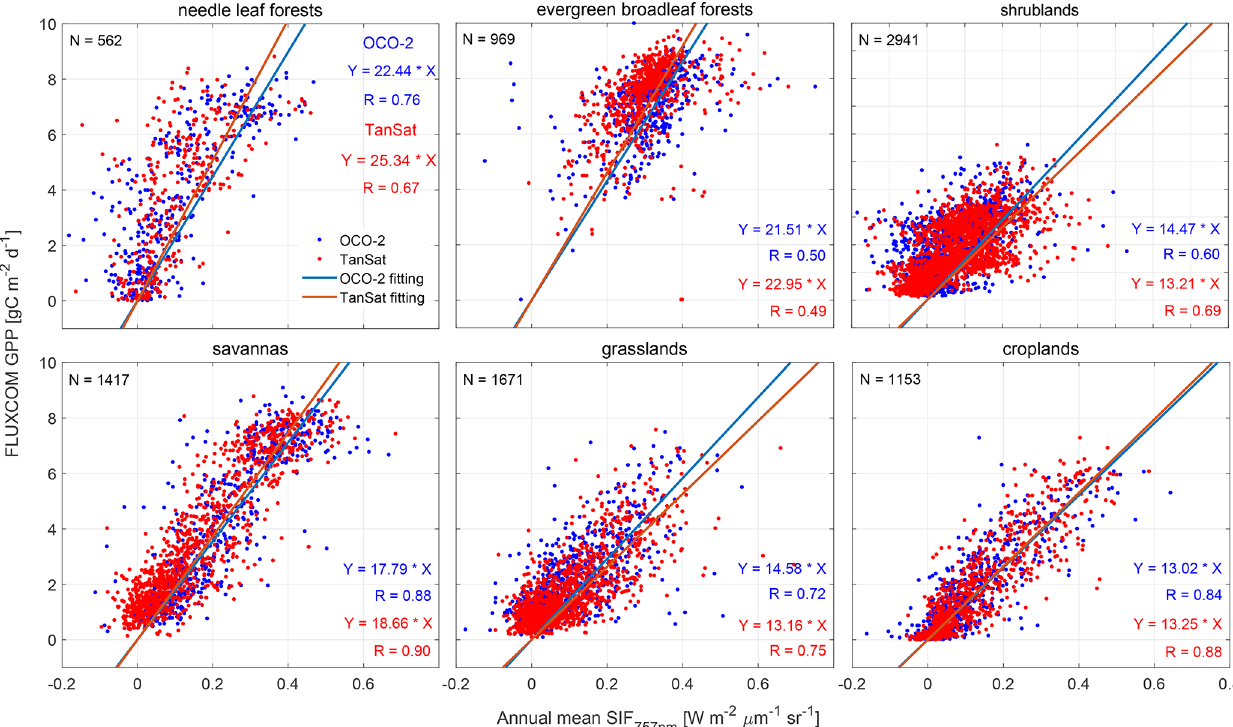
Figure 5. Relationship between annual mean SIF and FLUXCOM gross primary production (GPP) from March 2017 to February 2018. Blue and red dots represent OCO-2 and TanSat SIF grids, respectively. Fitted lines and statistics for OCO-2 and TanSat are shown in each